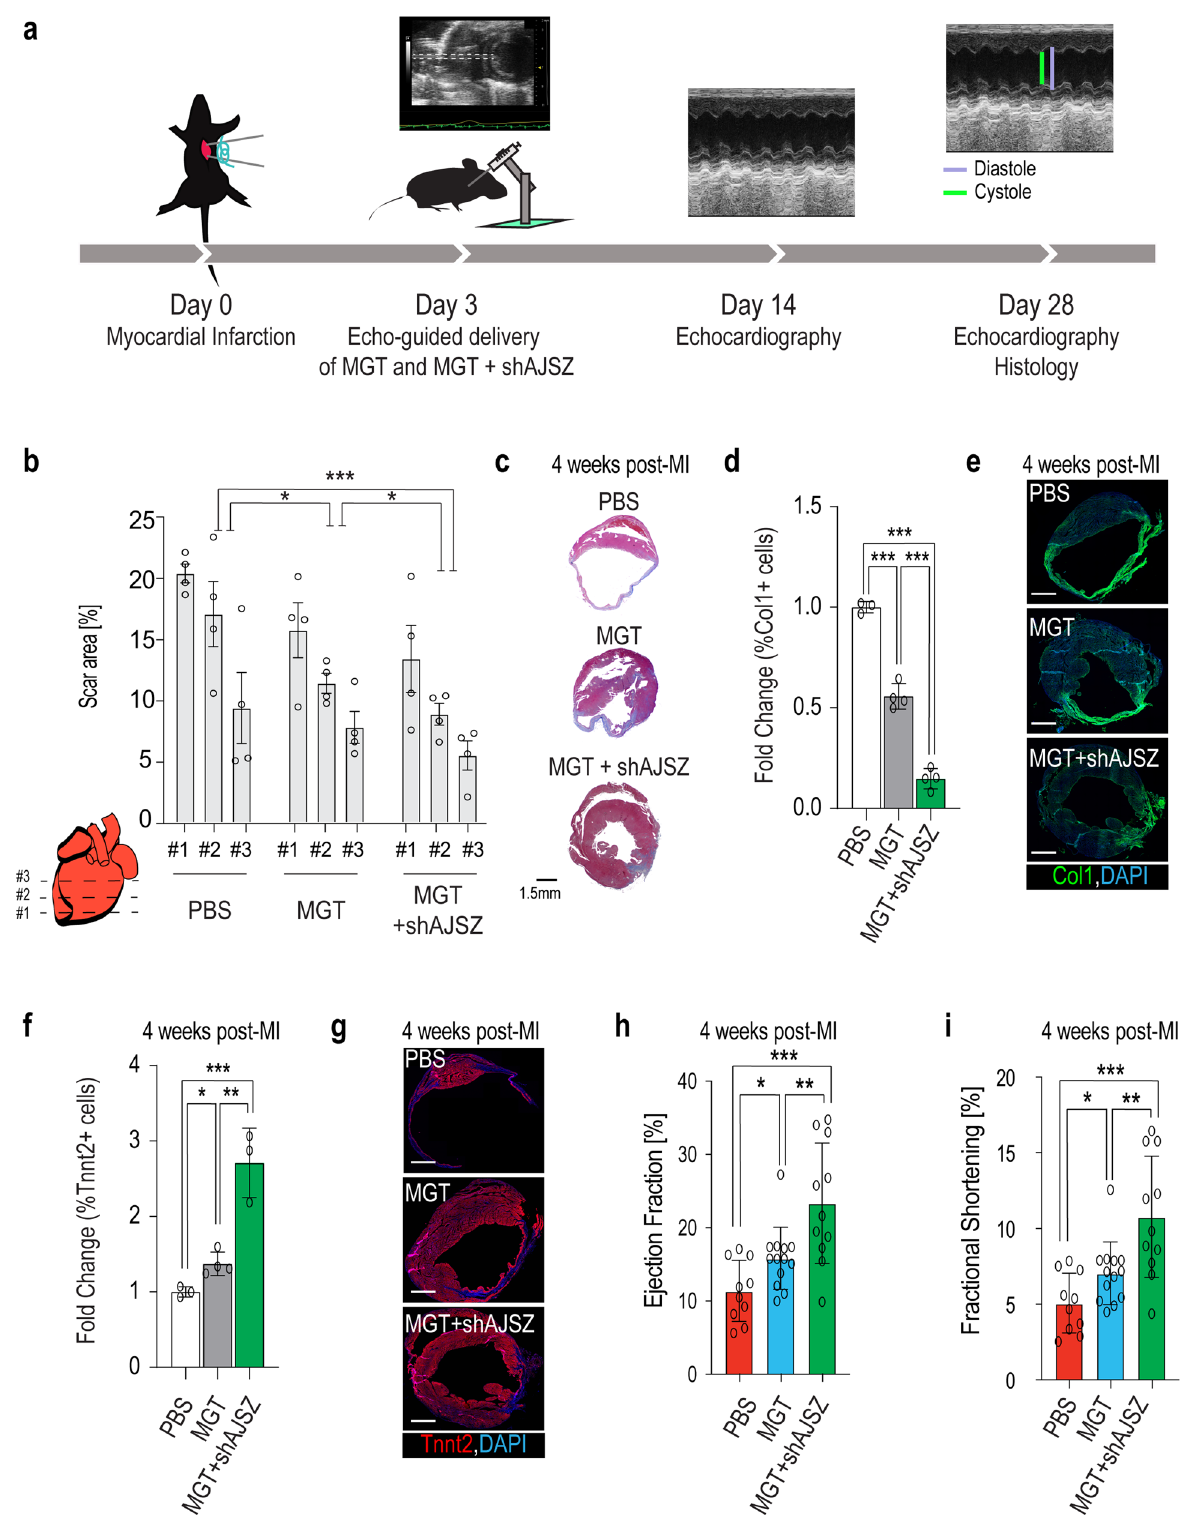
Fig. 7 | shAJSZ enhances MGT ’ s ability to improve heart function post-MI. a Schematic depicting the experimental strategy to test the role of AJSZ on heart function post-MI. b , d , f Quanti fi cation of scar area ( b ), fi brosis ( d ), and cardiac content ( f ) in PBS, MGT, and MGT+shAJSZ conditions 4 weeks after MI. n =4 per condition. c , e , g RepresentativehistologicalheartsectionsafterMassontrichrome staining (scar area) Scale bar: 1.5mm ( c ), Col1 ( fi brosis) ( e ), and Tnnt2 (cardiac content) ( g ) staining in PBS, MGT, or MGT+shAJSZ conditions. DAPI is shown in blue. h Ejection fraction (EF) and i fractional shortening (FS) of the left ventricle